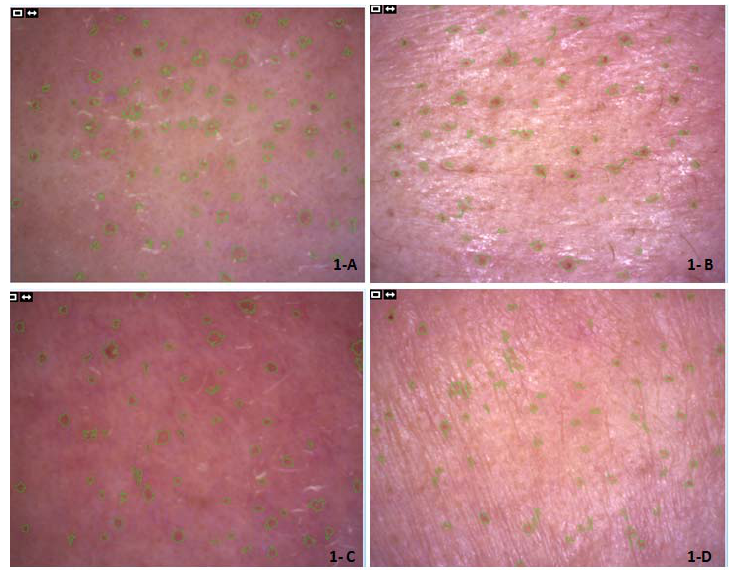
Figure 1. Graphic of typical results for the pore determination. ( 1 ‐ A ): Forehead on days 0 and ( 1 ‐ B ) Forehead on day 45; ( 1 ‐ C ) Right cheek on day 0; ( 1 ‐ D ) Right cheek on day 45. Both in volunteer 24. Pores can be visualized by the green marking. Table 2. Average results of pore evaluation on the forehead and the right cheek of volunteers.